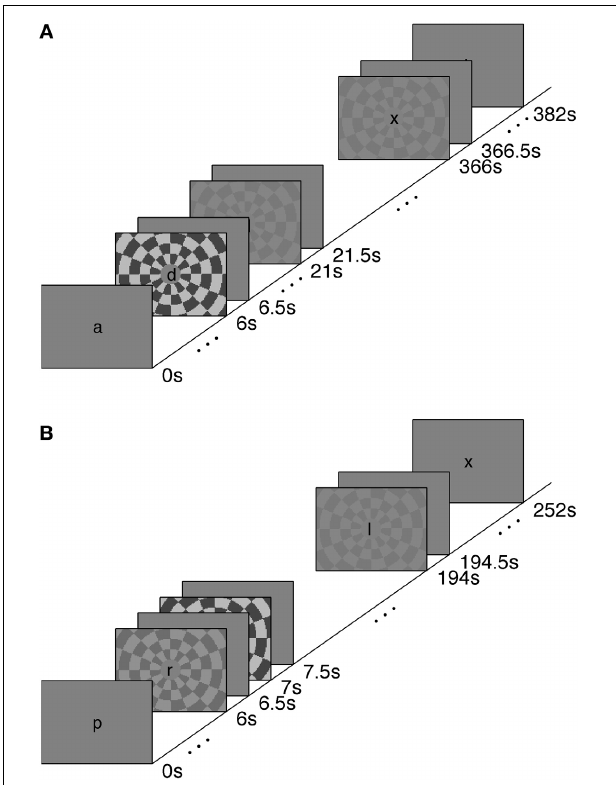
FIGURE 1 | Stimulus paradigms for Experiments 1 (A) and 2 (B). See text for